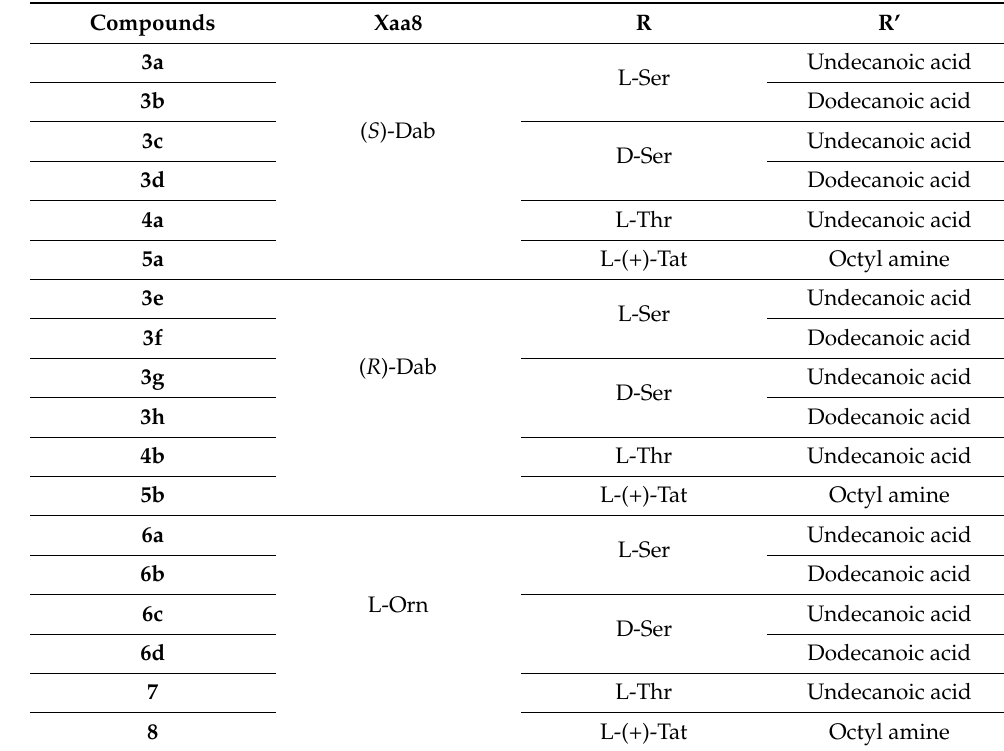
Table 1. Molecular design of Bk-1097